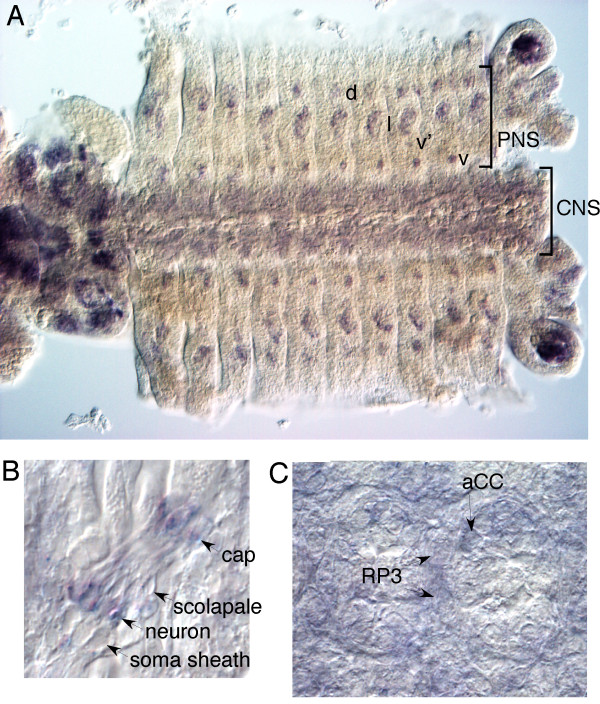
spire expression in the central nervous system and peripheral nervous system of Drosophila embryos. Wild-type embryos were collected, fixed, and analyzed by in situ hybridization with a probe that recognizes all spire isoforms, using alkaline phosphatase detection. Widespread expression of spire was observed in both the peripheral nervous system (PNS) and CNS of wild-type embryos. We did not discern any difference in the pattern of hybridization in lola mutant embryos. We also did not detect any difference in the strength of the spire signal, though this is not surprising given the small magnitude of the effect. (A) Filet preparation of entire embryo (stage 14). PNS and CNS are indicated with brackets. Dorsal, lateral, ventral' and ventral clusters of peripheral sensory organs are indicated as d, l, v' and v, respectively. Anterior is to the left. (B) High magnification view of a lateral sense organ cluster (stage 16) showing preferential expression in the neurons and cap cells of the chordotonal organs. Soma sheath and scolopale cells did not label detectably. (C) spire RNA was detected in many cells of the CNS. The motoneurons RP3 and aCC are indicated (arrows). Two segments are shown.